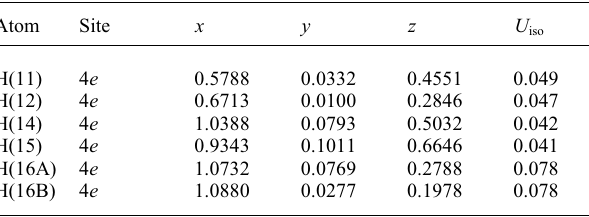
Table 3. Atomic coordinates and displacement parameters (in Å 2 )